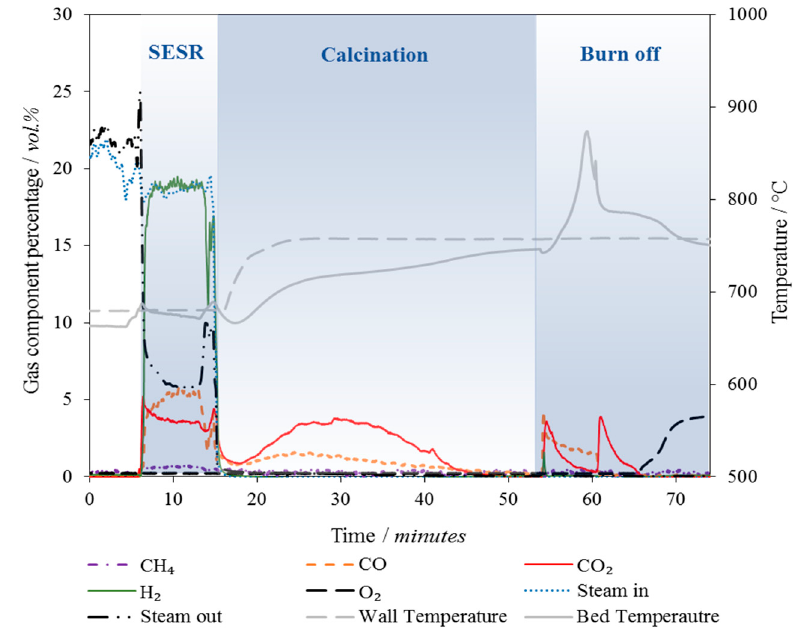
Figure 5. The gas and temperature response for 10 min of biomass Sorption Enhanced Steam Reforming (SESR), followed by calcination and coke burn-off.